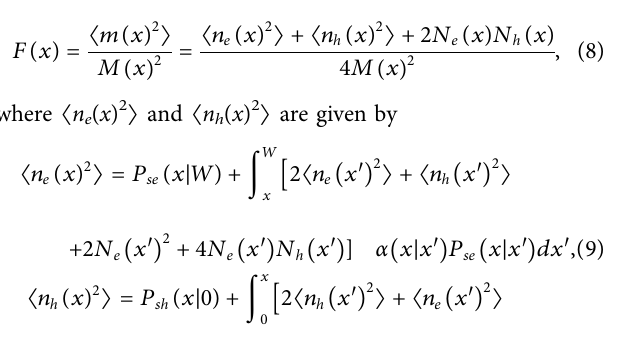
Frontiers in Physics |